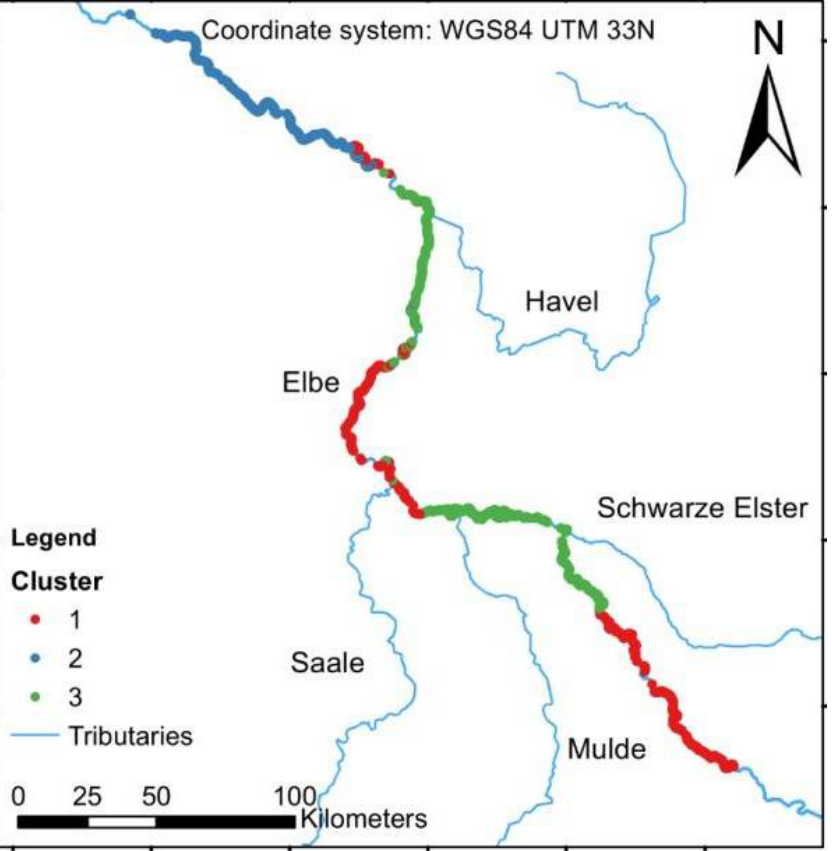
Figure 7. Spatial cluster membership distribution obtained from k-means clustering performed on BIOFISH parameters. Observation points are colored according to cluster membership.